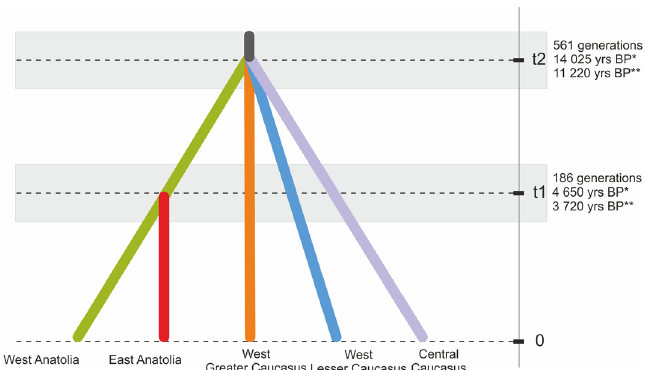
Figure 4. The best demographic scenario of divergence obtained for Pinus sylvestris in the South Caucasus and Anatolia based on nuclear microsatellites using DIYABC. *25 years as the generation time; **20 years as the generation time. t1—time of the divergence between West and East Anatolian lineages; t2—time of the divergence from the most recent common ancestor; 0—current time.